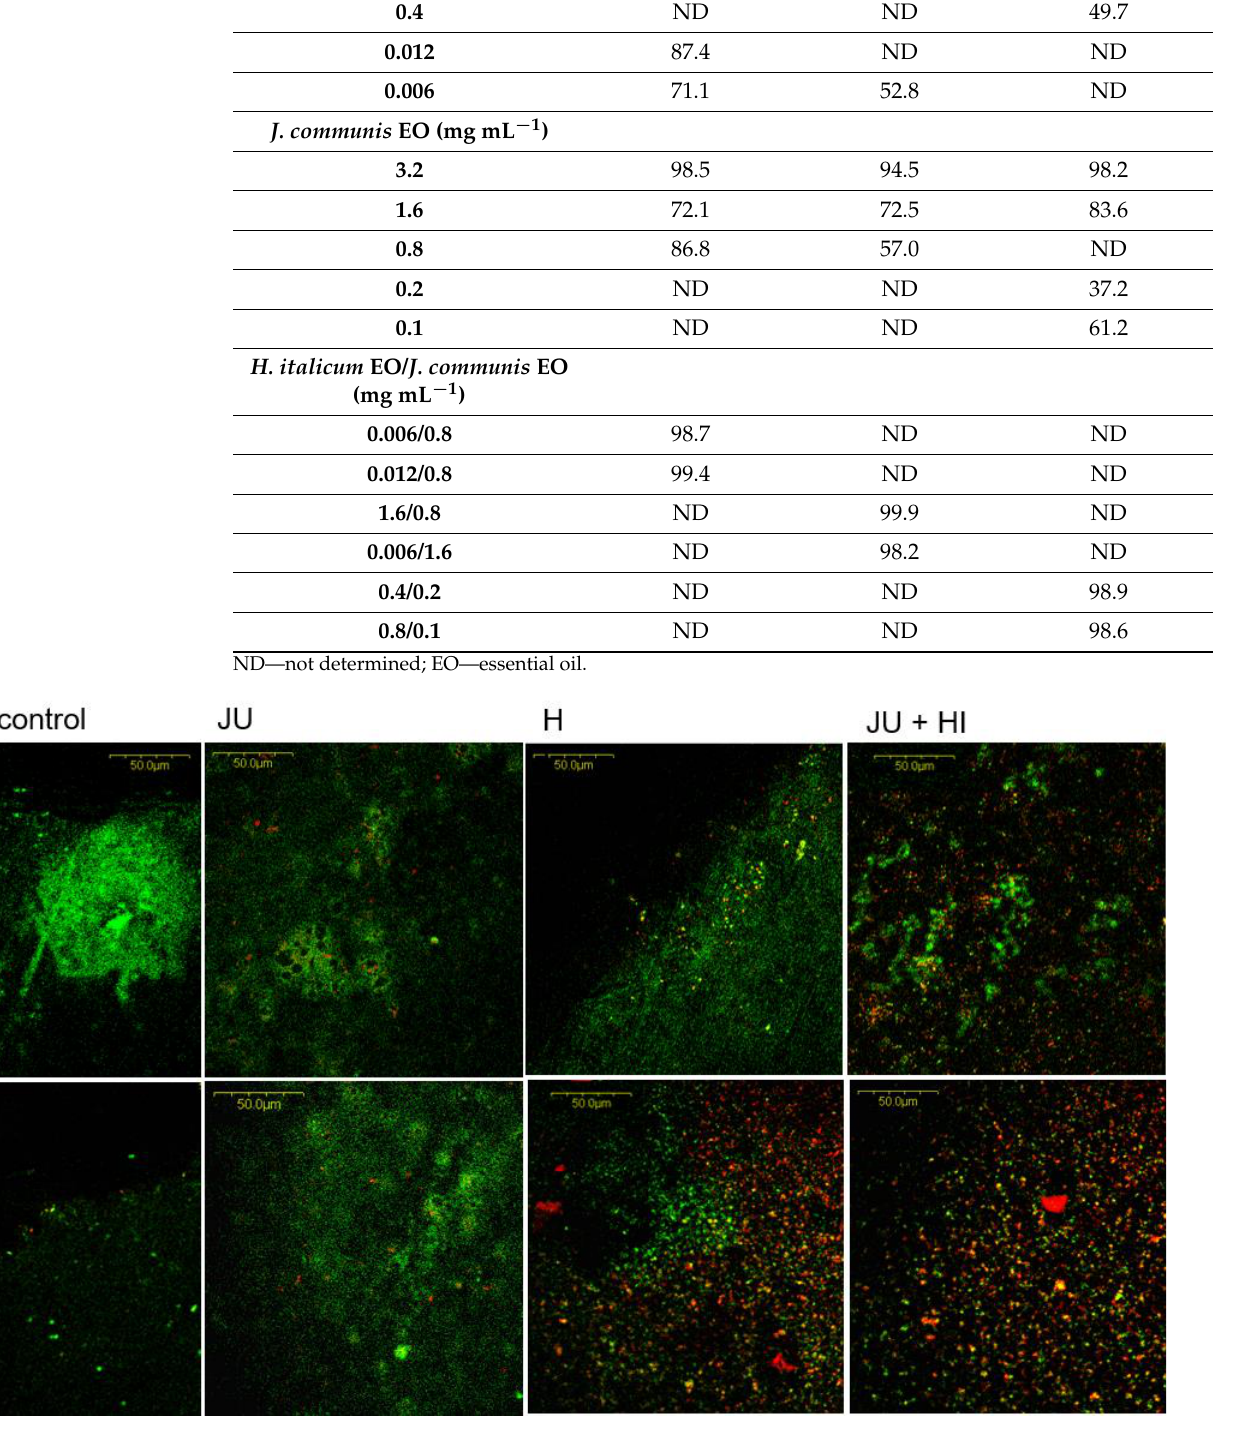
Figure 5. Live/dead stained images of Mycobacterium biofilms grown on stainless steel discs, performed by confocal laser scanning microscopy (CLSM) after treatment with J. communis (JU) and/or H. italicum (HI) EOs. M. avium was treated with JU 0.8 mg mL -1 and/or HI 0.012 mg mL −1 ; M. intracellulare was treated with JU 0.8 mg mL −1 and/or HI 1.6 mg mL −1 . Untreated mycobacterial cells served as controls. Performed at 40x magnification.